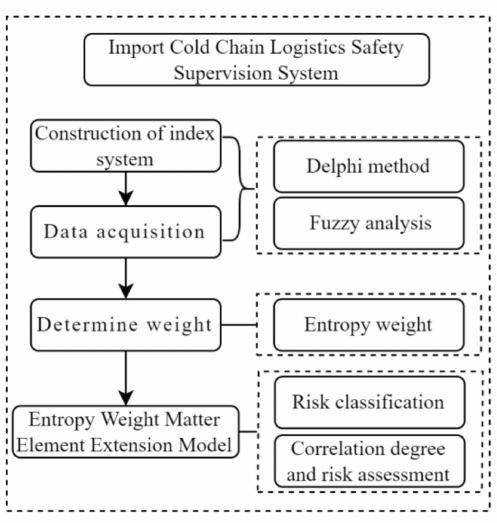
Figure 5. The architecture of the method.